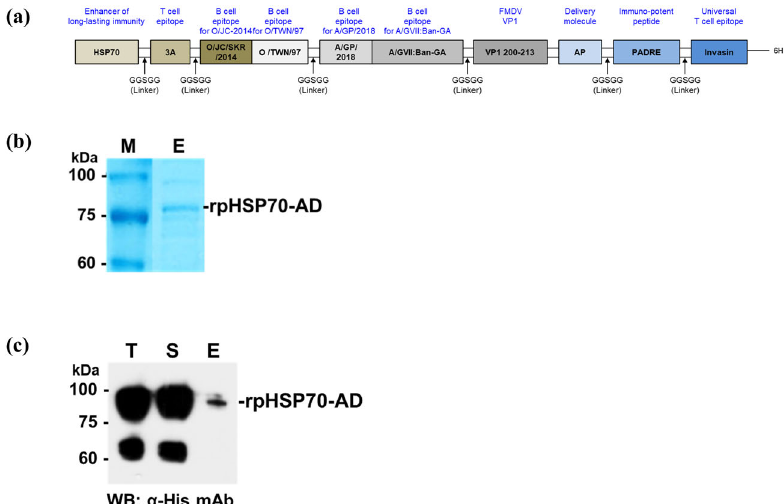
Fig. 1 A schematic diagram of the novel immunopotent porcine recombinant protein, rpHSP70-AD, and expression of rpHSP70-AD. Schematic diagram of the novel immunopotent porcine recombinant protein, rpHSP70-AD ( a ); The novel immunopotent recombinant protein rpHSP70-AD combines the multiple indicated active immunopotent domains. The detailed strategy is described in Methods, and the sequence information for each molecule is described in Supplementary Table 1. Sun-Gel-stained SDS-PAGE gel of rpHSP70-AD, M; molecular size marker, E; puri fi ed elution fraction ( b ); Western blot of puri fi ed recombinant rpHSP70-AD, T; total cell lysates, S; soluble fraction of cell lysates, E; puri fi ed elution fraction ( c